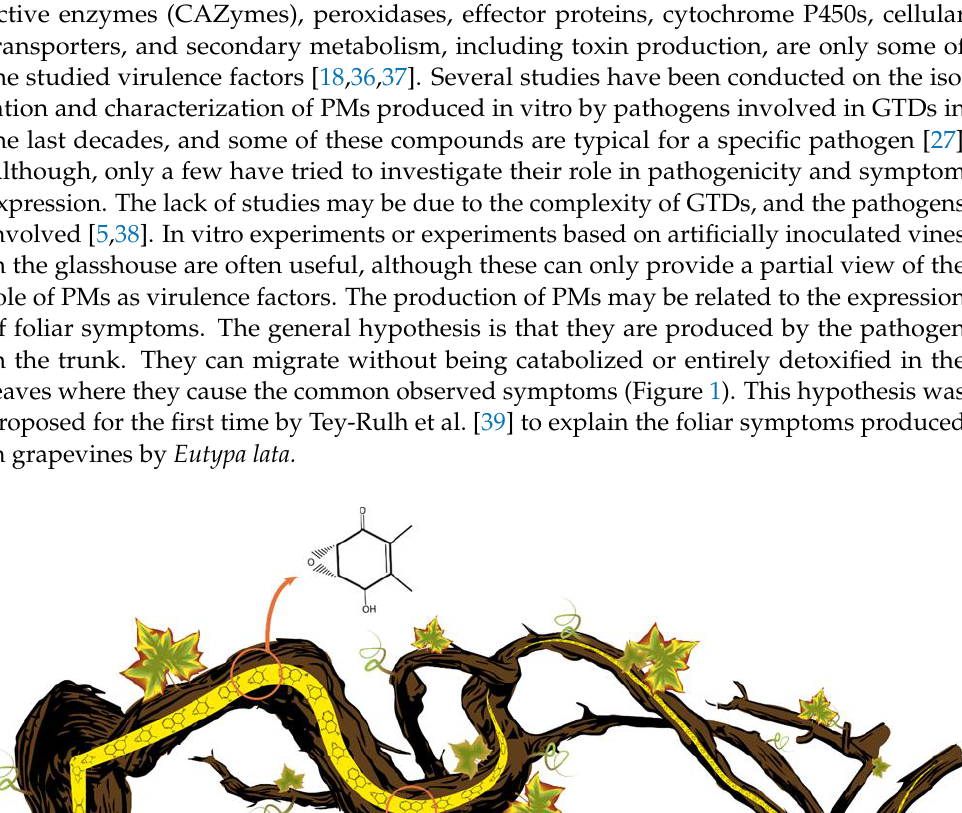
Table 1. Species of Phaeoacremonium and Cadophora involved in the Esca Complex. Genus